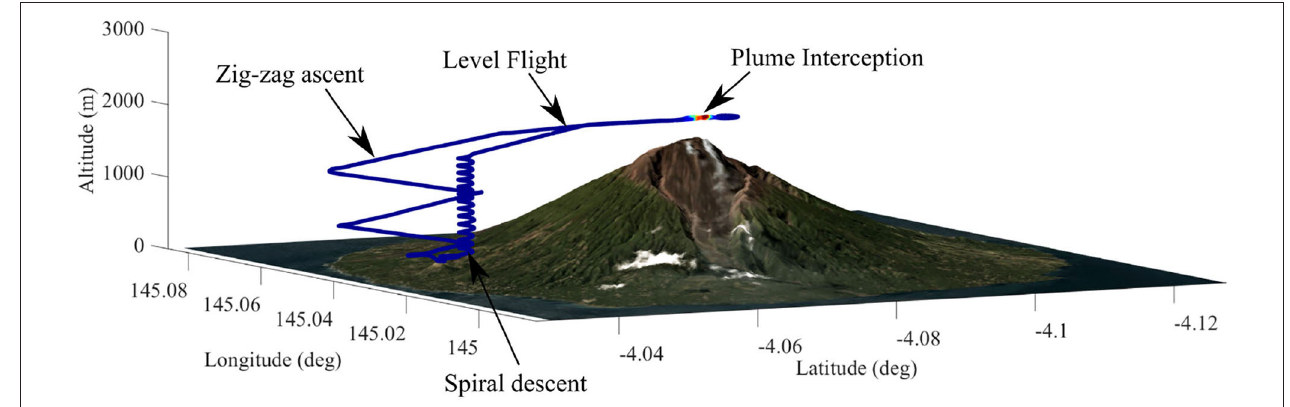
FIGURE 4 | The mission profile comprised a zig-zag ascent, level flight during the plume interceptions, and a spiral